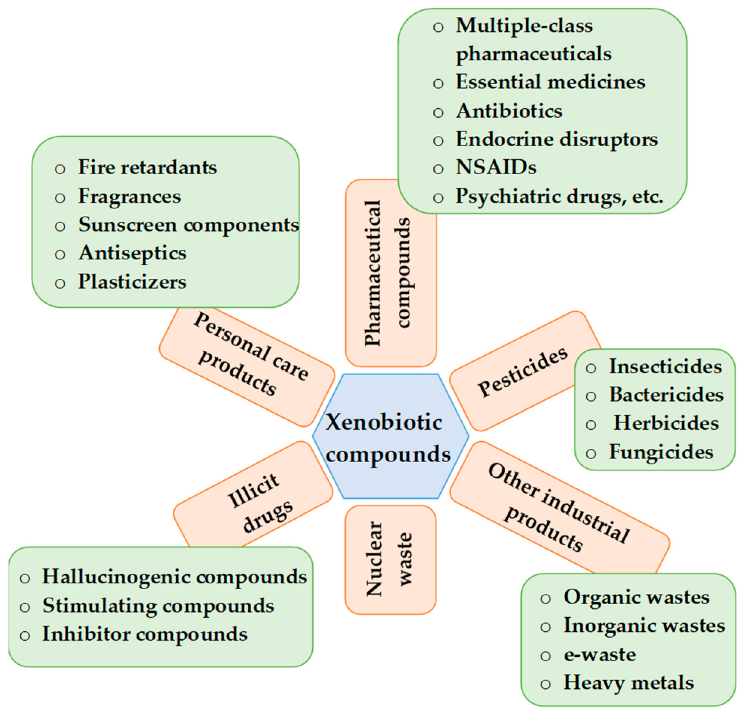
Figure 1. Xenobiotic compounds (modified by [22]).